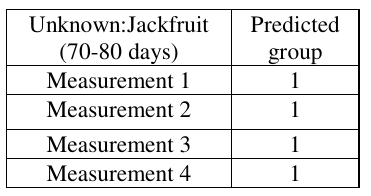
Table 2: Classification results of unknown samples constructed by means of CDA. Referring to the predicted group shown, all unknown samples are correctly classified to their respective group.